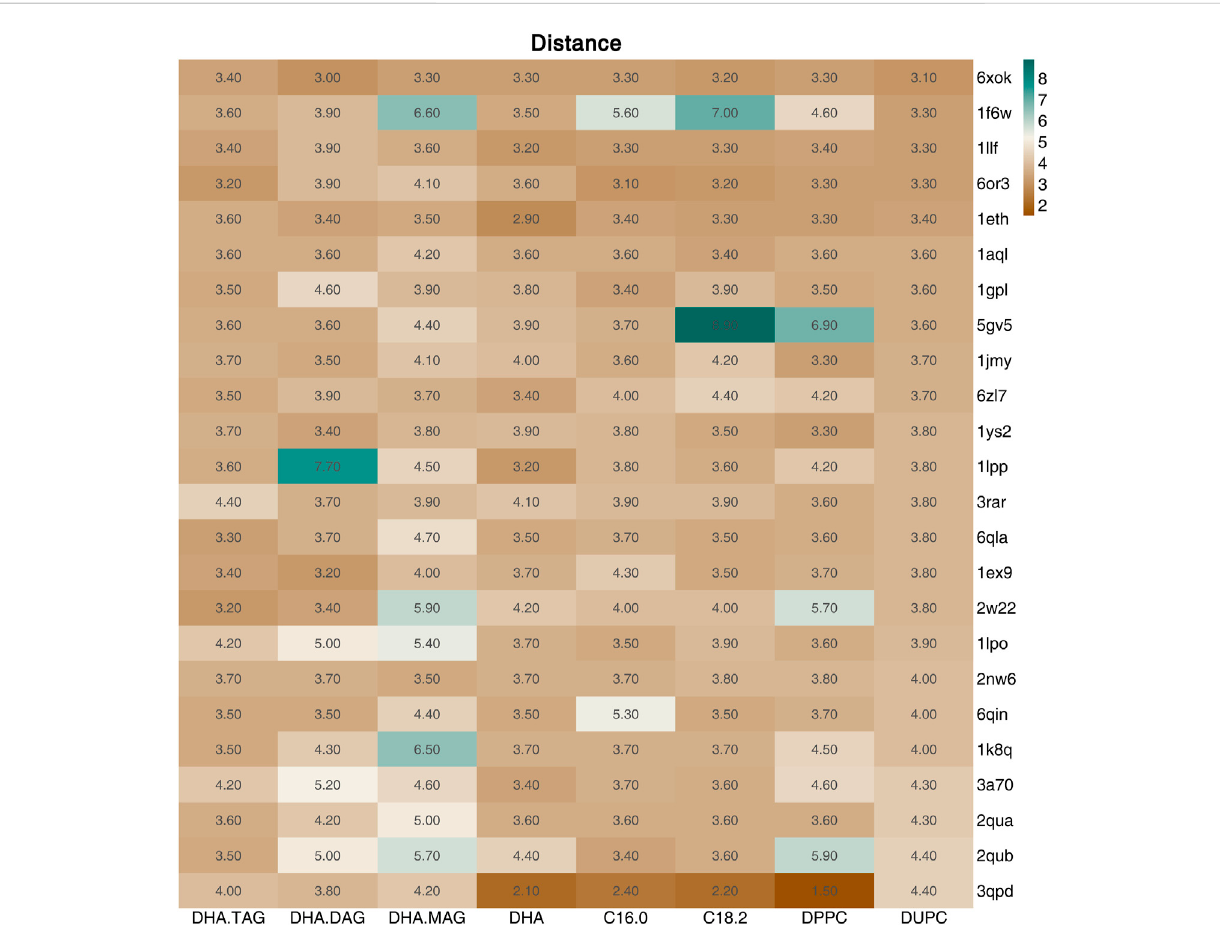
FIGURE 2 Distance (Å)betweentheO γ on theSerofthescreenedlipases(Af fi nity ≤ − 5.0 kcal/moland Distance ≤ 4.5 Å)and theacylcarbonatom oftheligand.